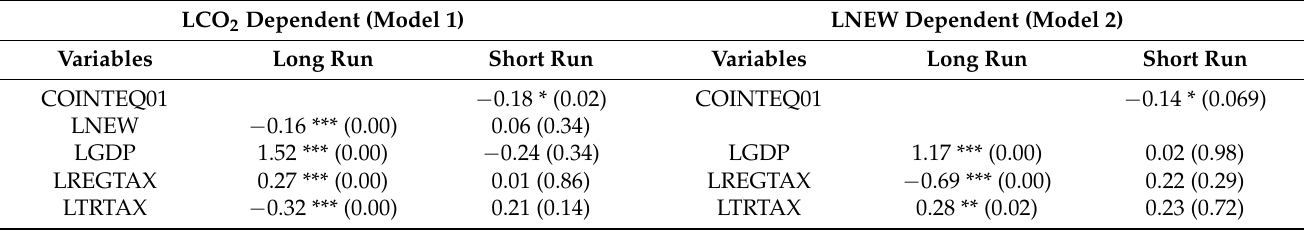
Table 6. Auto Regression Distributed Log Model